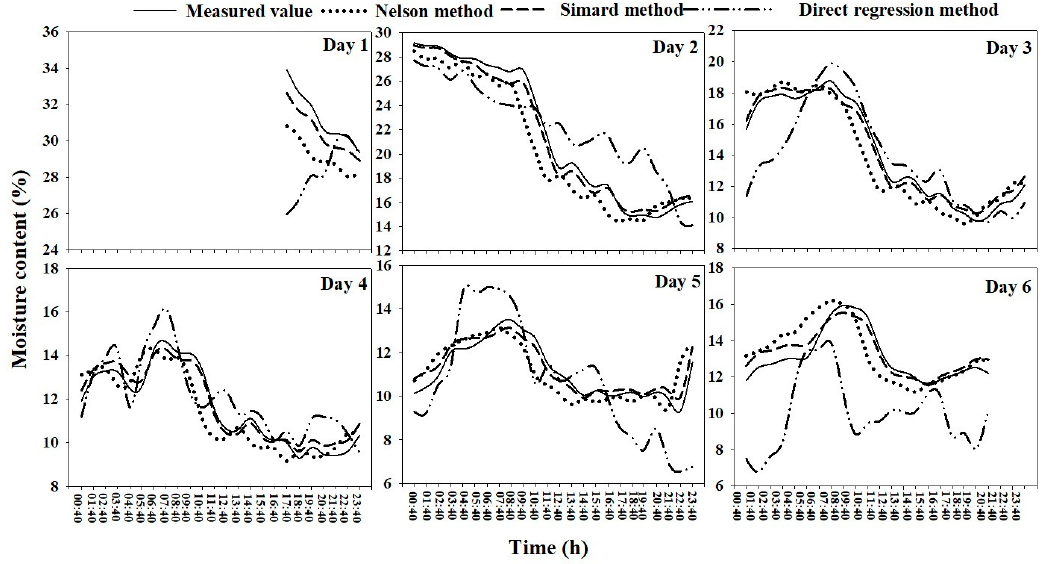
Figure 6. Measured and predicted values of the diurnal variation in litter moisture content of Korean pine.